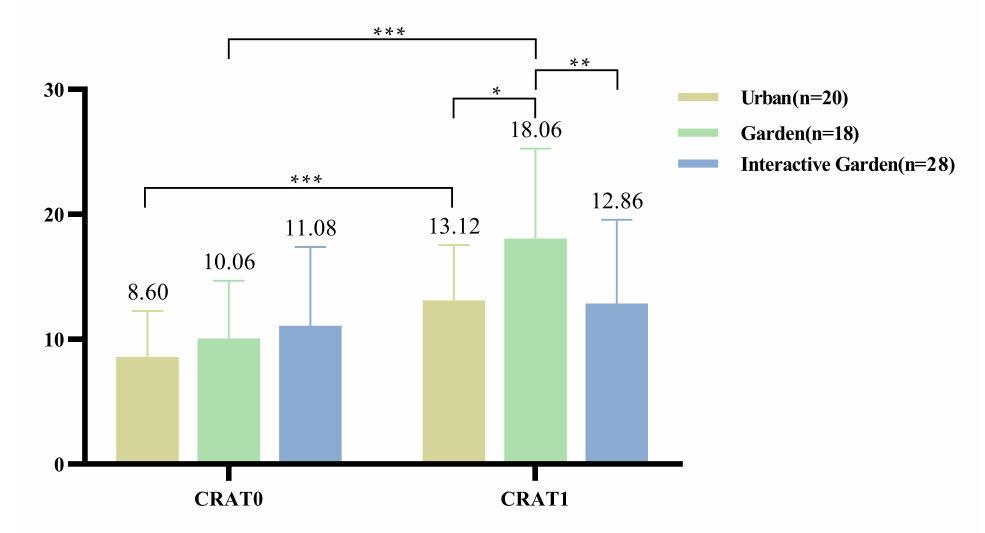
Figure 8. Descriptive statistical results of the total score of CRAT. Note: * represents p < 0.05, ** represents p < 0.01, and *** represents p <